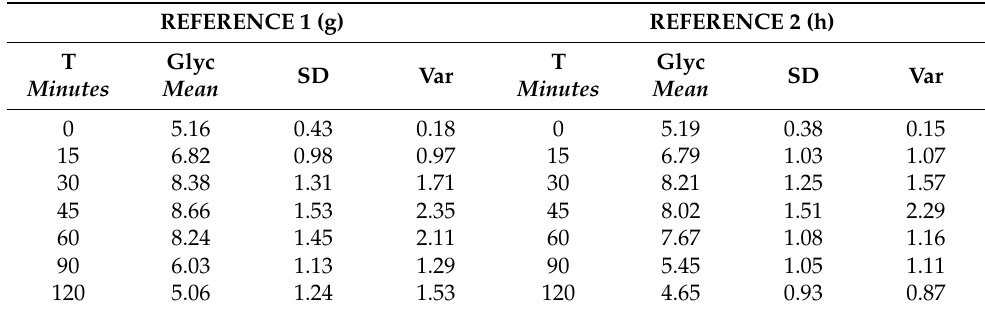
Table 7. For reference food (50 g of glucose in 250 mL mineral water) tables (g,h) report the average values recorded for glycemia (mmol/L), SD (Standard deviation), and Var (Variance) in enrolled volunteers. Reference food was tested twice in two different sessions (Reference 1/Reference 2).